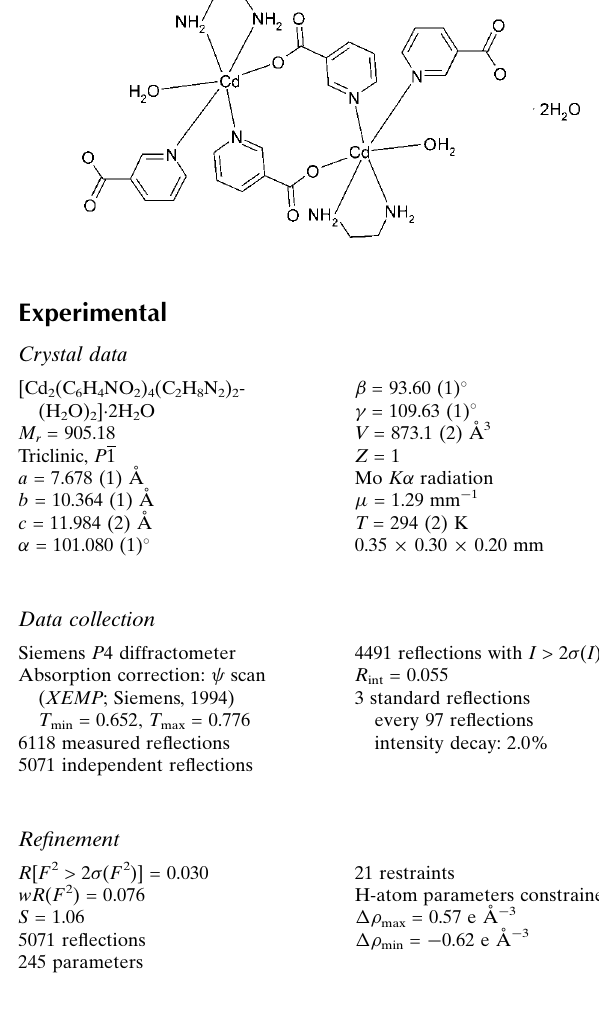
Data collection